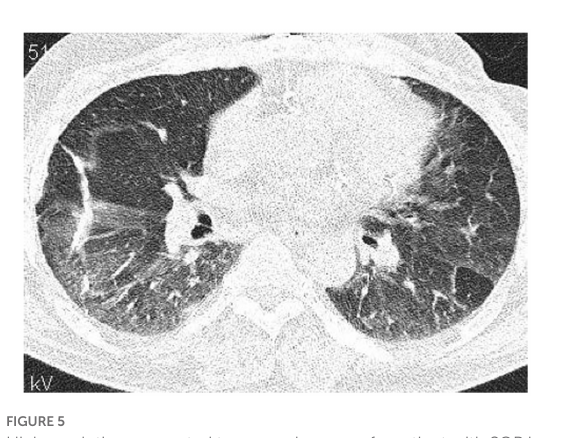
FIGURE 5 High resolution computed tomography scan of a patient with SOP in the course of dermatomyositis. In both lungs evidence of GGO with patchy distribution and parenchymal banding with “arcade” sign typical of OP. Status post lung biopsy on the right side.